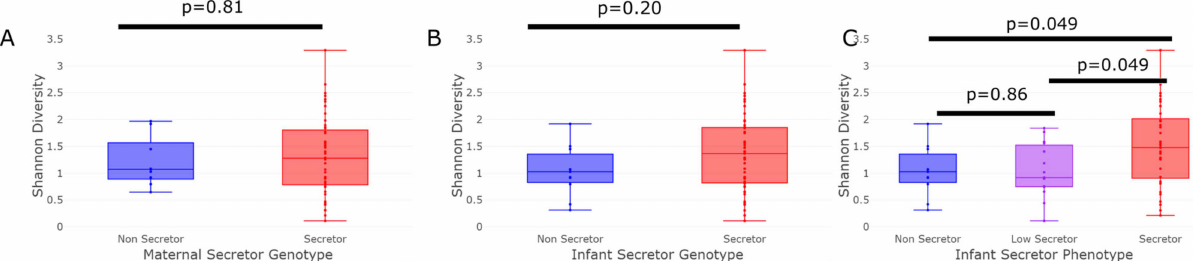
Figure 2. Alpha diversity by secretor status. The presence of secretor (presence/absence of functional FUT2 gene product) milk from a mother was not accompanied by significant changes in the overall alpha-diversity of an infant’s gut microbiota ( A ) (Kruskal–Wallis p = 0.81). The secretor genotype of the infants was not significantly associated with a change in the alpha-diversity of an infant’s gut ( B ) (Kruskal–Wallis p = 0.20). However, the secretor phenotype (measured as the presence of the H-antigen blood group antigens in the saliva) of the infants revealed no significant differences in the alpha diversity measured as the Shannon index between the low- and non-secretors (Kruskal–Wallis p = 0.86), but the Shannon index of the full-secretor group was significantly higher than that of the low- and non-secretors ( C ) (Kruskal–Wallis p =